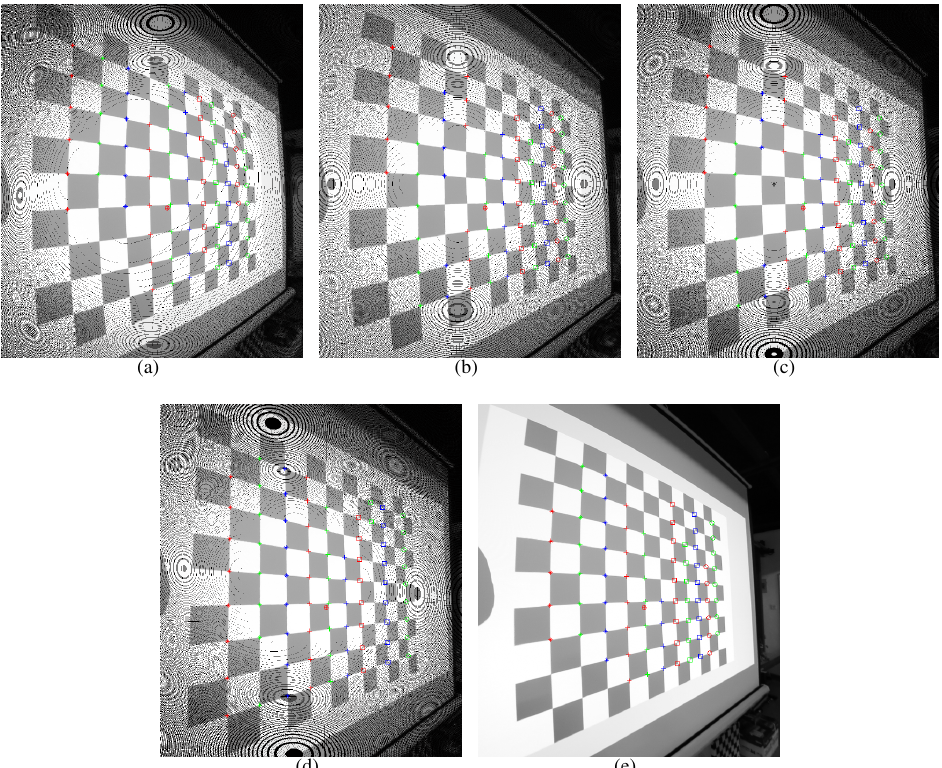
Figure 7: The corrected corner points at the vertical direction using the RT model (a),FET model (b),PFET model (c),RF model (d),division model (e)